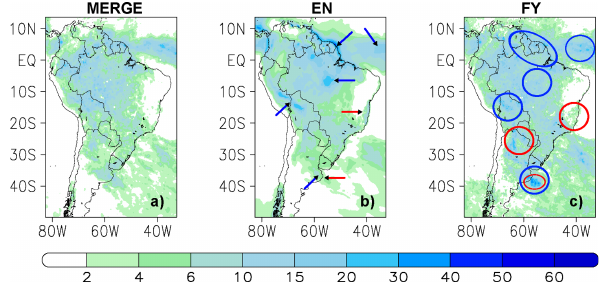
Fig. 4. 24-h accumulated precipitation for January 2006 (in mm): (a) observation (MERGE), (b) using the ensemble simple mean (EN) and (c) field weighted by FY. The blue (red) arrows and cir- cles point out areas where the FY performance is better (worse) in comparison with